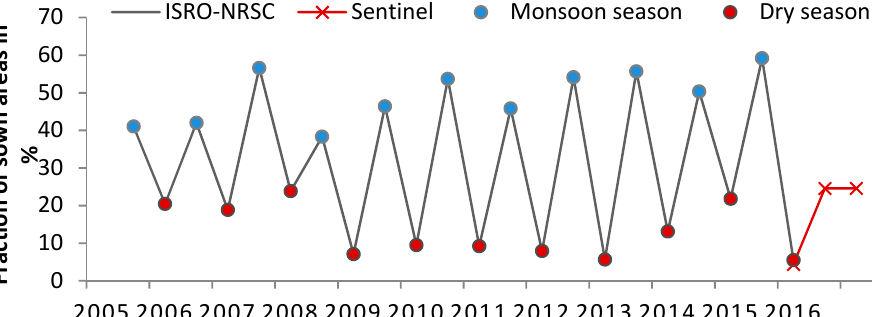
Figure 6. Rabi ( red dots ) and Kharif ( blue dots ) fractions of surface sown within the Kudaliar watershed since 2005. The black line data are published by the ISRO-NRSC in the framework of the NICES programs. The seasonal extents estimates from our study are in red crosses. They correspond to the addition of irrigated and non-irrigated crops areas.